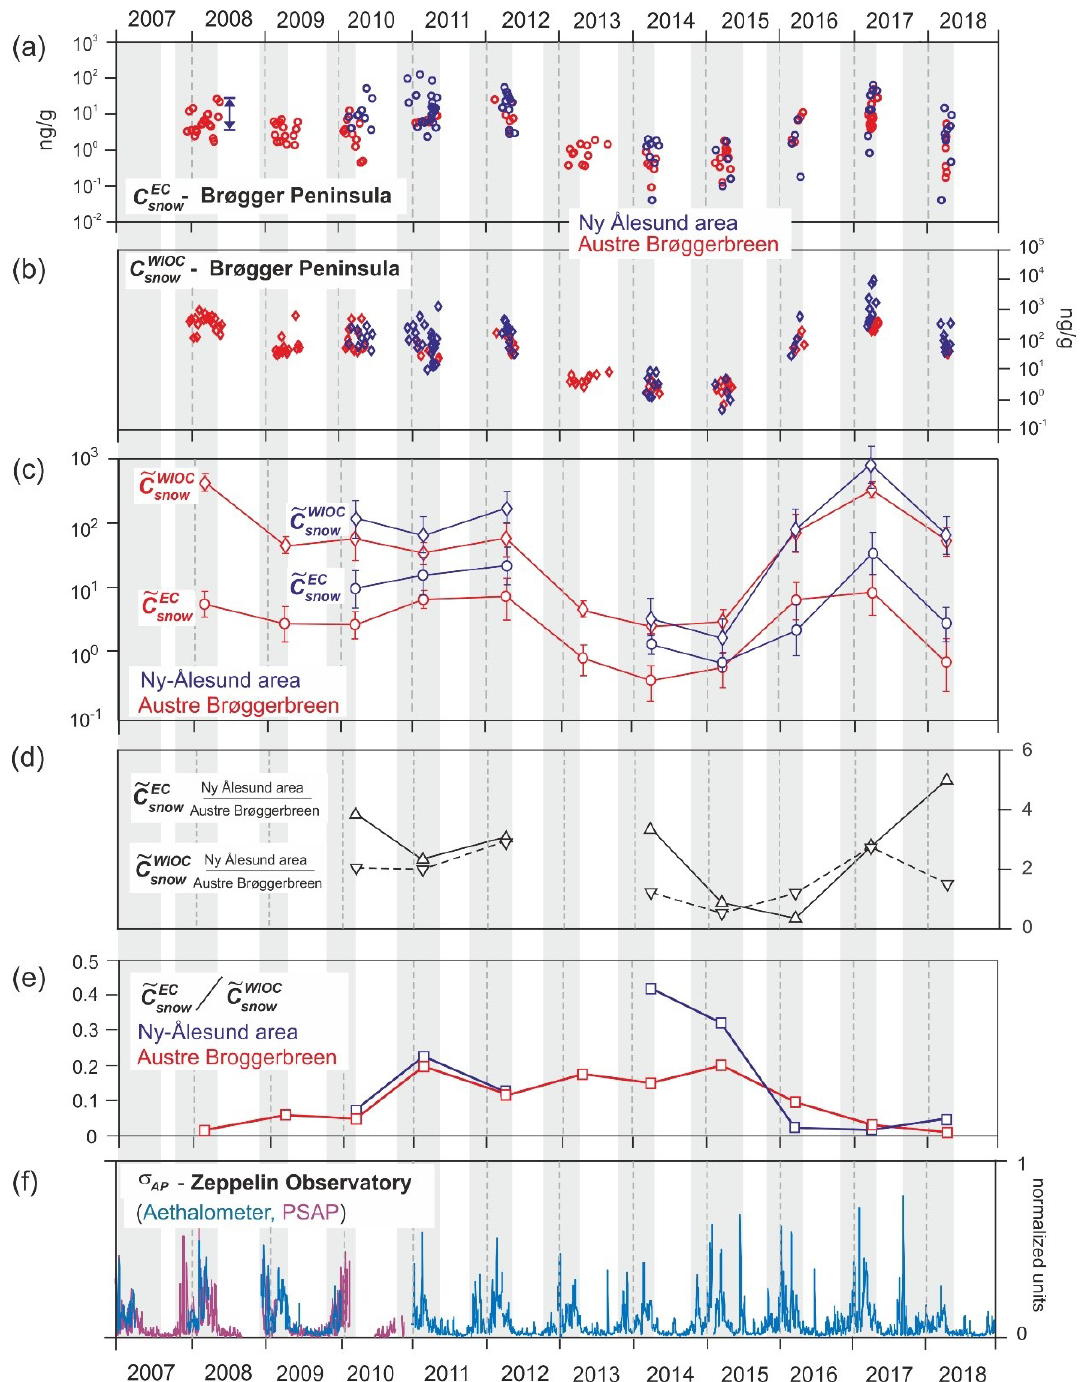
Figure 5. (a) C EC snow and (b) C WIOC snow in surface layers on central Brøgger Peninsula, Svalbard, 2008–2018. The double-headed arrow in (a) is the interquartile range of C EC snow measured near Ny-Ålesund in March 2008 by Aamaas et al. (2011). (c) Median values of the data ( ˜ C EC snow , ˜ C WIOC snow ) near Ny-Ålesund and on Austre Brøggerbreen, with error bars representing 95% confidence bounds (see text for details). (d) Ratio of ˜ C EC snow (upright triangles) and of ˜ C WIOC snow (inverted triangles) near Ny-Ålesund and on Austre Brøggerbreen. (e) Ratio between ˜ C EC ˜ C WIOC snow and snow at these sites. (f) Weekly averages of the BC aerosol absorption coefficient σ AP measured by two methods at Zeppelin Observatory (normalized units; Eleftheriadis et al., 2009). The latter data are only shown here to highlight the timing of winter/spring maxima in BC aerosol mixing ratios in the study